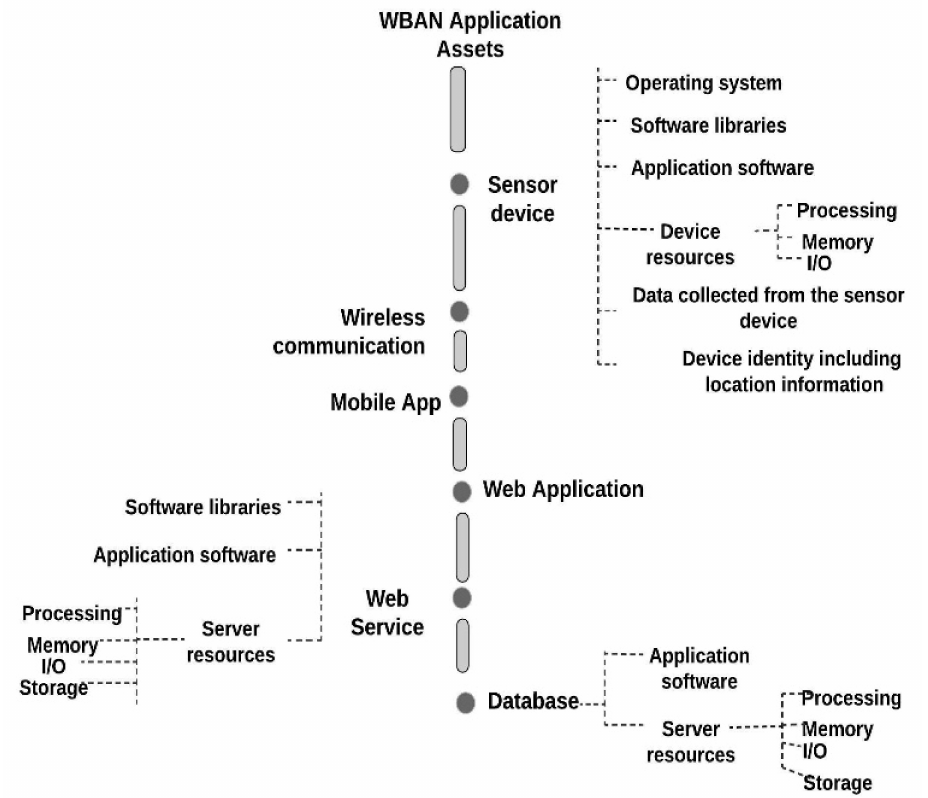
Figure 7. List of assets for WBAN